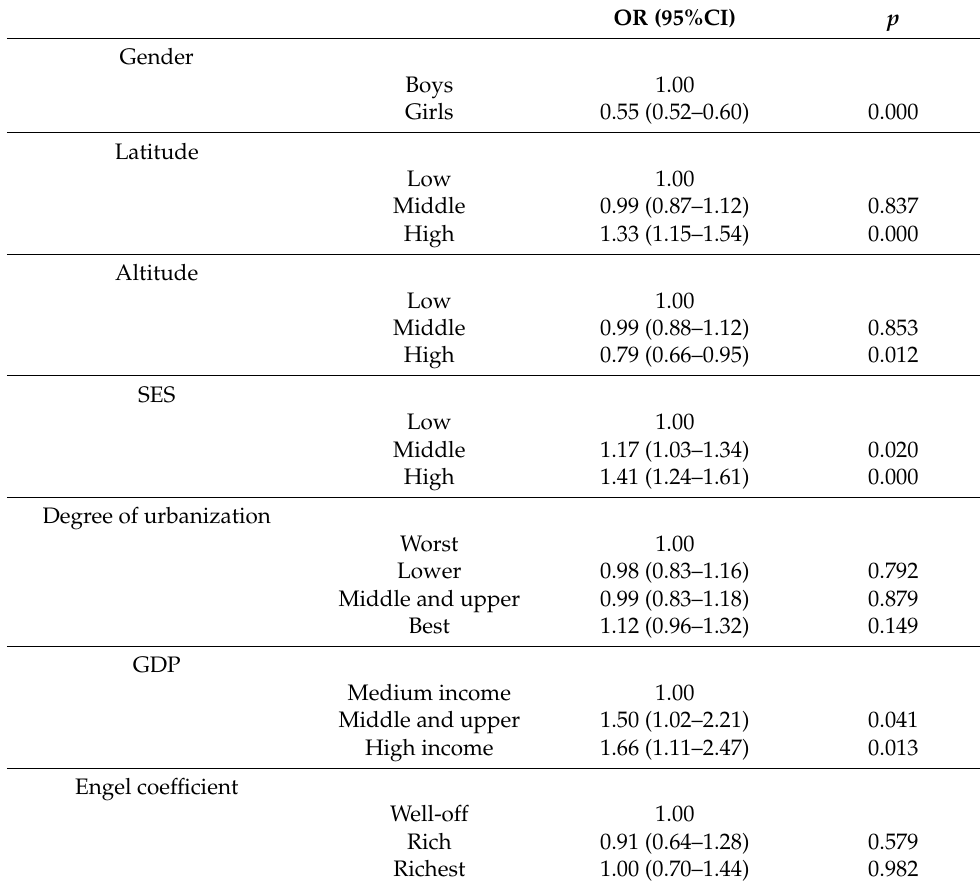
Table 6. Logistic regression of the influential factors of overweight in children and